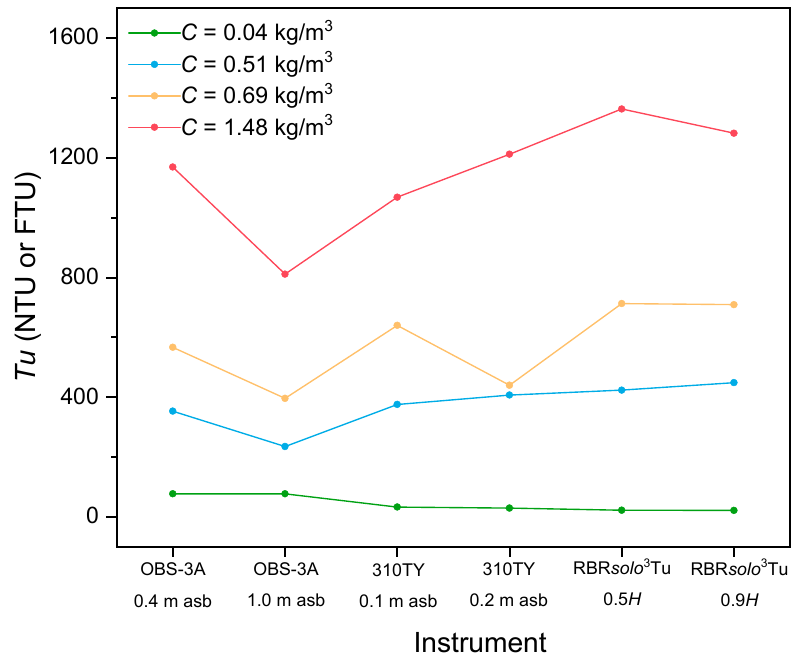
Figure 8. Outputs from the six turbidimeters in response to an identical SSC (0.04, 0.51, 0.69, and 1.48 kg/m 3 ).